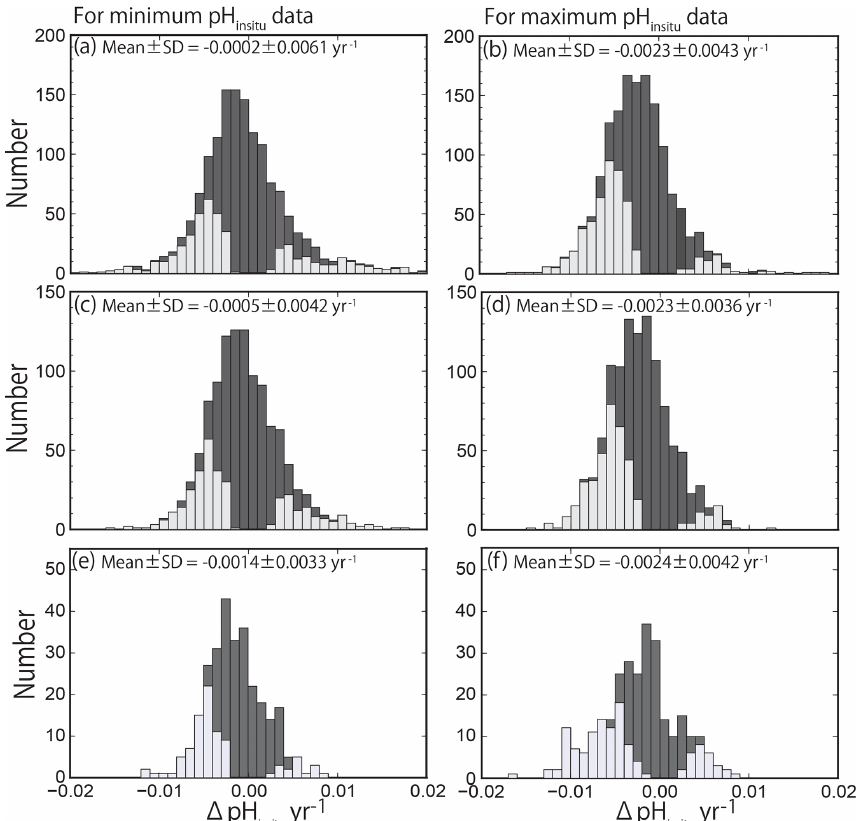
Figure 7. Histogram of pH trends, represented by (cid:49) pH insitu , showing the slopes of the linear regression lines for the annual minimum (a, c, e) and maximum (b, d, f) pH insitu data at each monitoring site. The histograms in (a, b) , (c, d) , and (e, f) show three scenarios: (a, b) all 1481 available sites with continuous records before quality control, (c, d) 1127 sites without outliers, and (e, f) 289 sites that meet the strictest criterion. The trends with statistical significance are denoted by light